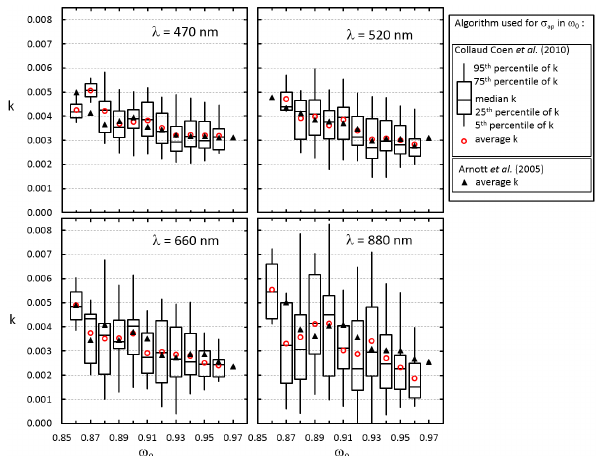
Figure 8. Daily averaged compensation parameters of blue ( λ = 470nm), green ( λ = 520nm), red ( λ = 660nm), and near- infrared ( λ = 880nm) light classified into 0.01 wide bins of the single-scattering albedo ( ω 0 ) at the same wavelengths. The box plots present the 5th, 25th, 50th, 75th, and 95th percentiles and the circles the averages in each bin. Most ω 0 bins are based on σ a p cal- culated with the Collaud Coen et al. (2010) algorithm; the black tri- angles are the averages of compensation parameters classified into ω 0 bins with the σ a p calculated by using the Arnott et al. (2005)